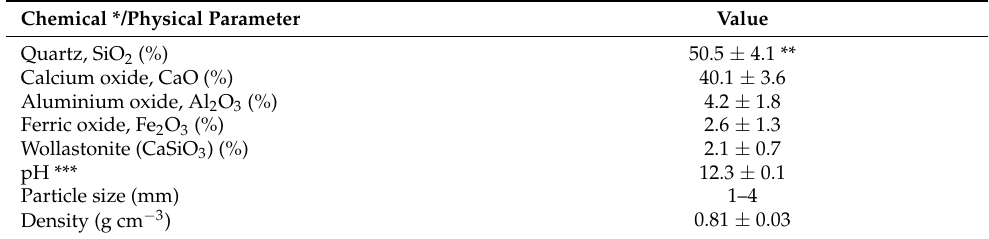
Table 1. Chemical and physical parameters of the Polonite filter material used in the experiment. Chemical */Physical